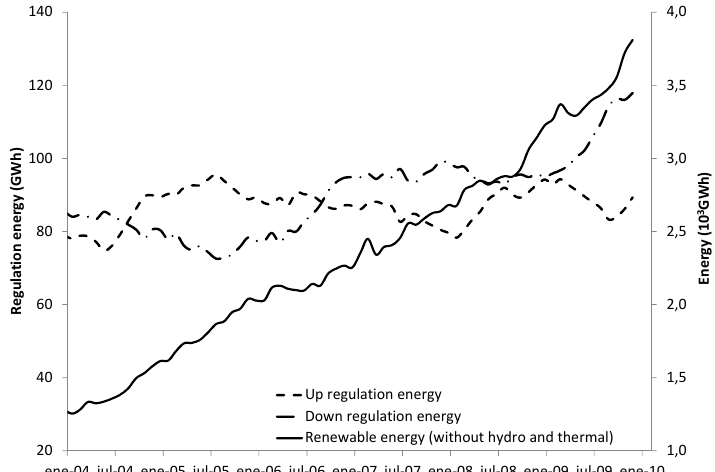
Figure 1. Moving average of up- and down-regulation energy and renewable energy production in the Spanish power